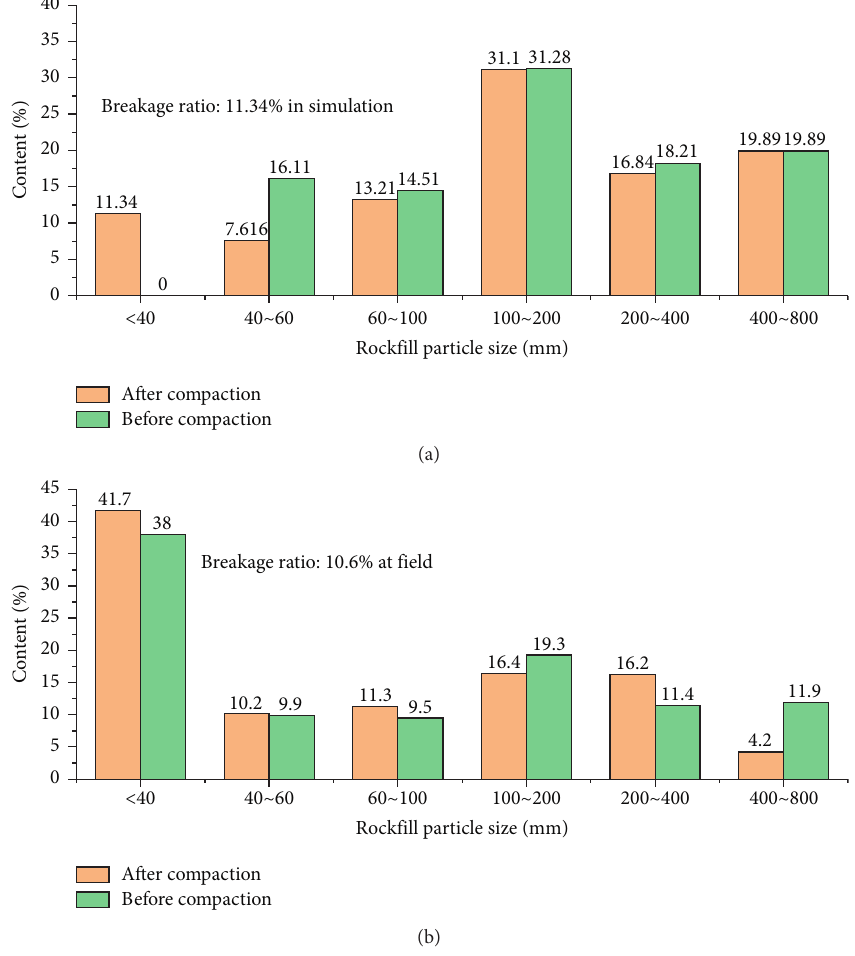
Figure 16: PSD analysis of rockfill particles after compaction at field (16T-800 mm). (a) Numerical simulation; (b) field